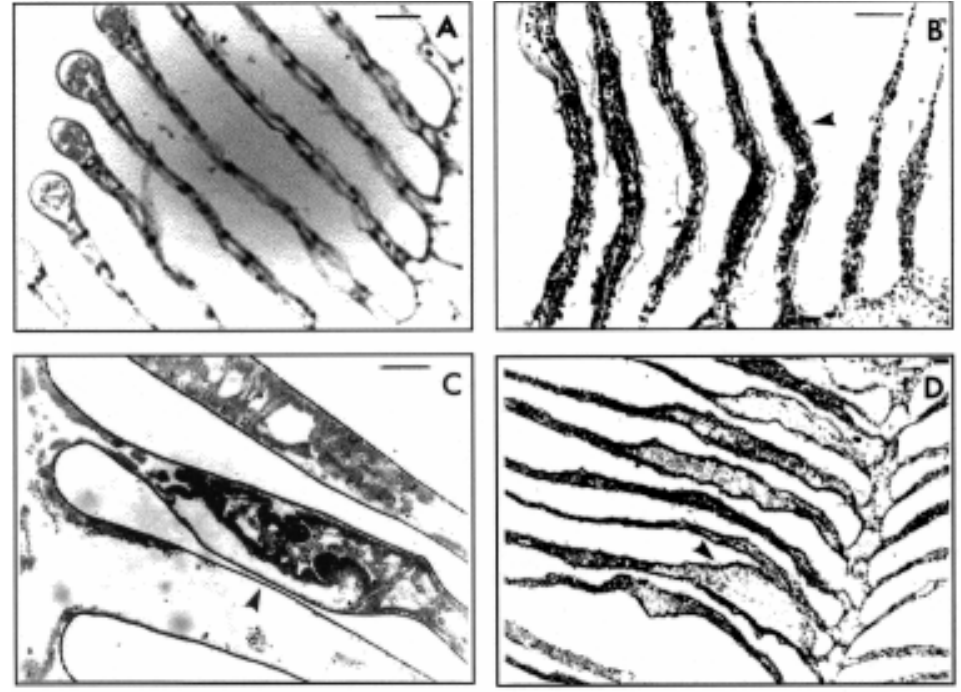
Figure 2 - Pathologies of the res- piratory gills observed in both acute and chronic assays at 12‰ salinity. A , Normal architecture (control); B , hyperplasia